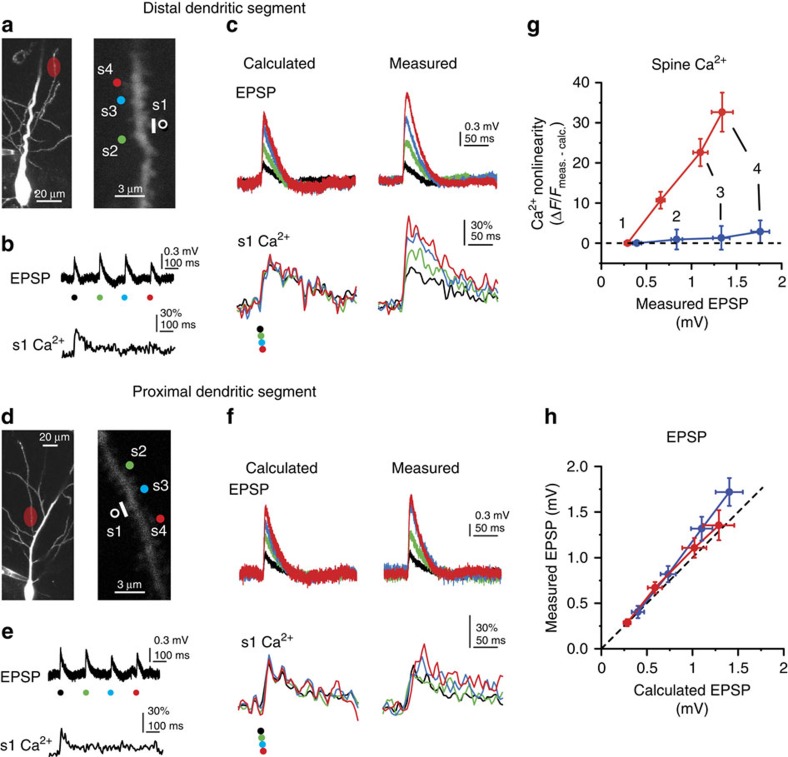
Cooperative spine head Ca2+ signalling in distal but not proximal dendritic segments.(a) Left: 2P z-stack of a CA1PC, with the uncaging location indicated in red at a distal site on an oblique dendrite. Right: magnified image of the stimulated segment. The four stimulated spines are indicated. (b) Representative recording of uncaging-evoked somatic EPSPs (upper trace) and Ca2+ signal in the first spine (lower trace) by individual stimulation of the four spines shown in a. (c) Calculated (left) and measured (right) somatic voltage traces (upper) and spine Ca2+ signals in s1 (lower) achieved by synchronous stimulation of the spines in increasing numbers (black: s1 alone; green: s1+s2; blue: s1+s2+s3; red: s1+s2+s3+s4). Note that, in the absence of interspine interactions, spine Ca2+ signals are expected to remain unaffected by stimulation of other inputs. d–f same as a–c, for spines stimulated at a proximal site on an oblique dendrite. (g) Quantification of cooperativity of synaptic Ca2+ signalling by calculating the nonlinear component of spine Ca2+ signals (measured minus calculated) at distal (red, n=18 spines, 6 cells, s1 and s2 data pooled) and proximal (blue, n=13 spines, 5 cells, s1 and s2 data pooled) dendritic segments, as a function of the somatically measured EPSP with increasing number of stimulated spines. (h) Measured versus calculated peak somatic EPSPs evoked at distal (red, n=10 experiments) and proximal (blue, n=7 experiments) dendritic segments with increasing number of stimulated spines. Group data are presented as mean±s.e.m. calc., calculated; meas., measured.